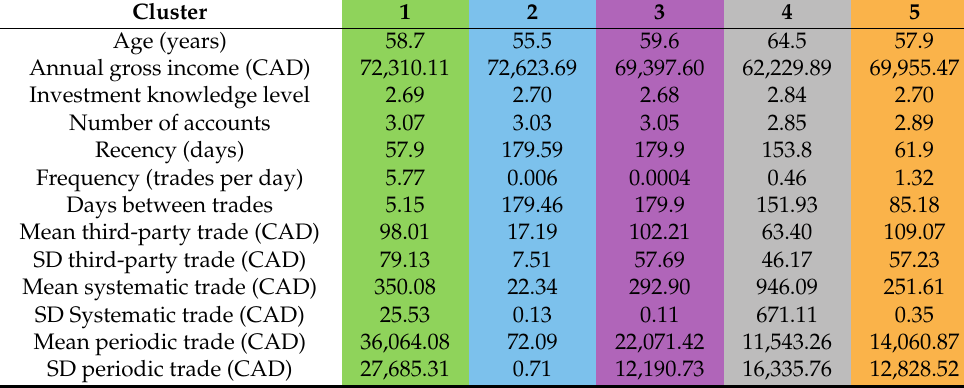
Table 5. Mean values of the numeric features of the optimal cluster centroids. The column colours assigned to each cluster are universal in this paper.